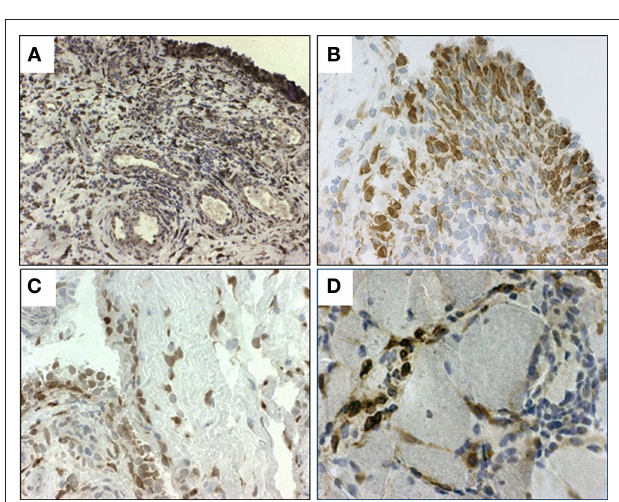
. Cyclooxygenase (Cox)-1 or 2 2 by mPGES-1. Alternatively, 2 2 2 . 2